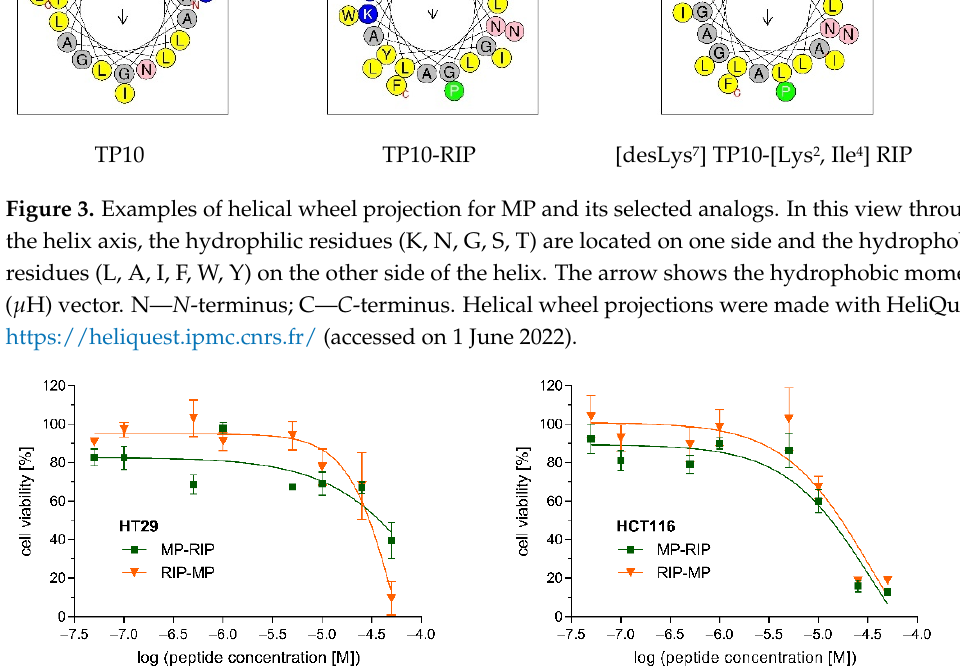
Figure 4. Effects of MP-RIP and RIP-MP on the viability of HT29 ( left ) and HCT116 ( right ) cells. Cells were incubated with various concentrations of peptides for 24 h and cell viability was assessed by MTT assay. Plots present mean ± SEM from three independent experiments performed in triplicate. X axis represents peptide concentration in logarithmic scale. Y axis represents cell viability expressed as a percentage relative to the untreated control cells incubated without peptides.